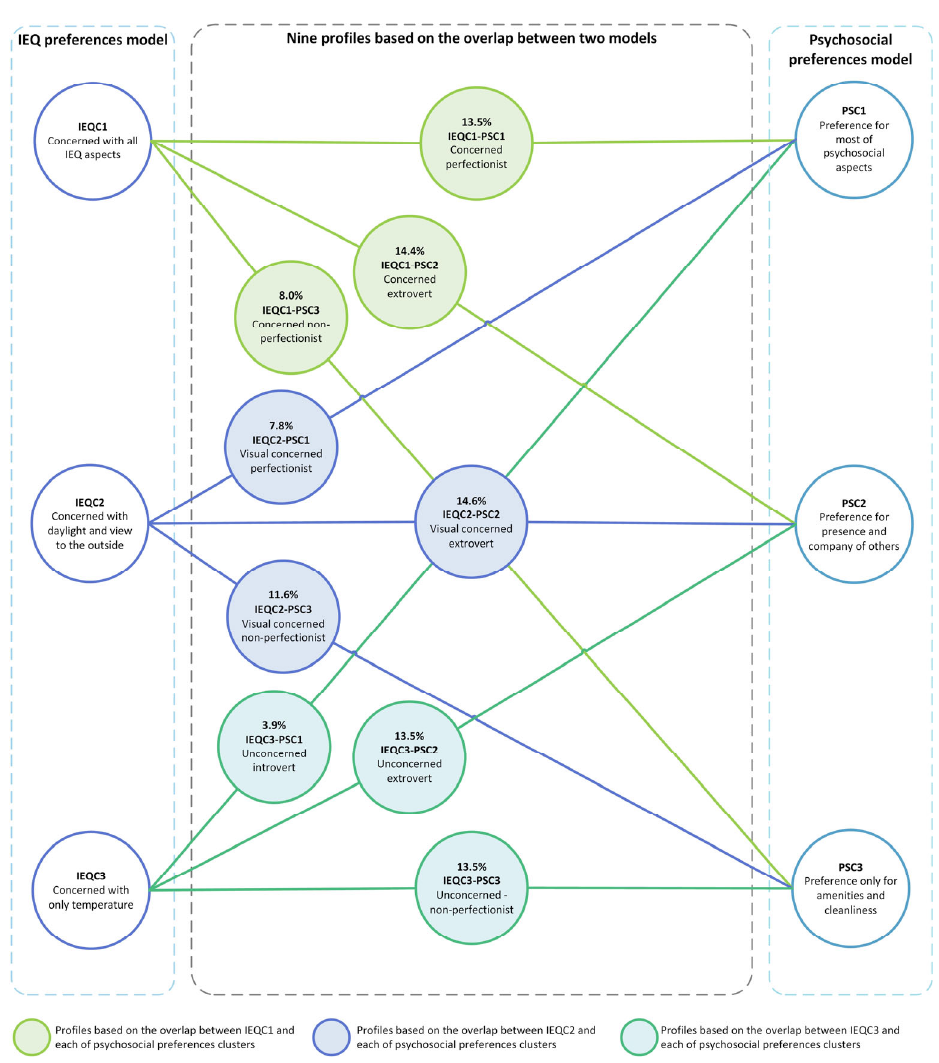
Figure 3. The nine profiles of students based on the overlap between the IEQ preferences model and psychosocial preferences model. Table 5. Description of the overlap profiles between the two clusters